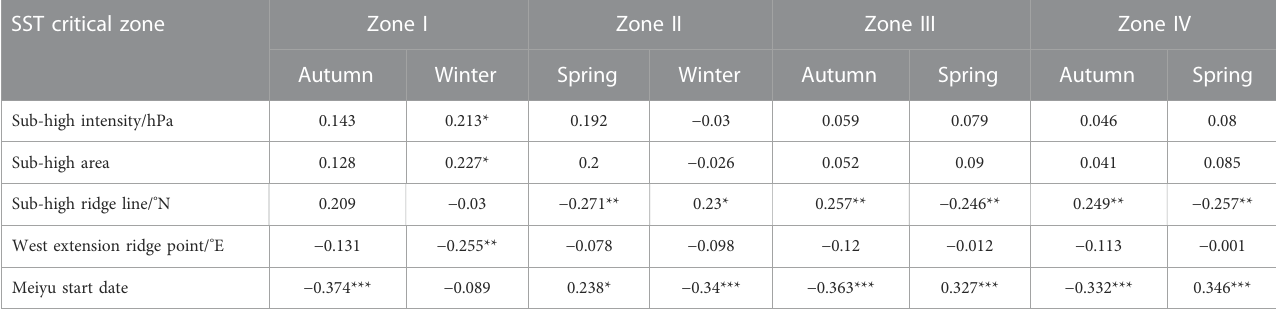
Paci fi c Ocean. The mean SSTA of the (10 ° S- 10 ° N, 60 ° - 100 ° E) region is selected to represent the equatorial Indian Ocean region (Zone I); the mean SSTA of the (15 ° -25 ° N, 60 ° -130 ° E) region represents the Bay of Bengal — South Sea region (Zone II); the (5 ° S-20 ° S, 150 ° -80 ° W) region